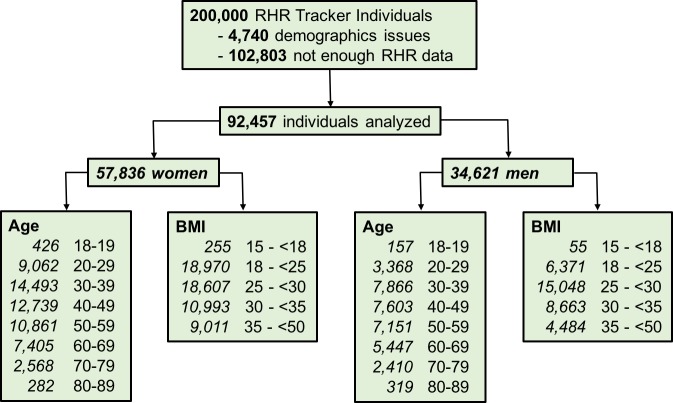
Subject selection for the study.We first removed users of resting heart rate (RHR) tracking devices based on demographic characteristics: age under 18 years, no sex specified, or body-mass index (BMI) outside the range of 15–50 kg/m2. Then we removed users who did not have at least 2 days per week of use, with the device worn 20 hours or more per day, for a minimum of 35 weeks. The demographic and clinical data for the resulting cohort divided by gender are shown.